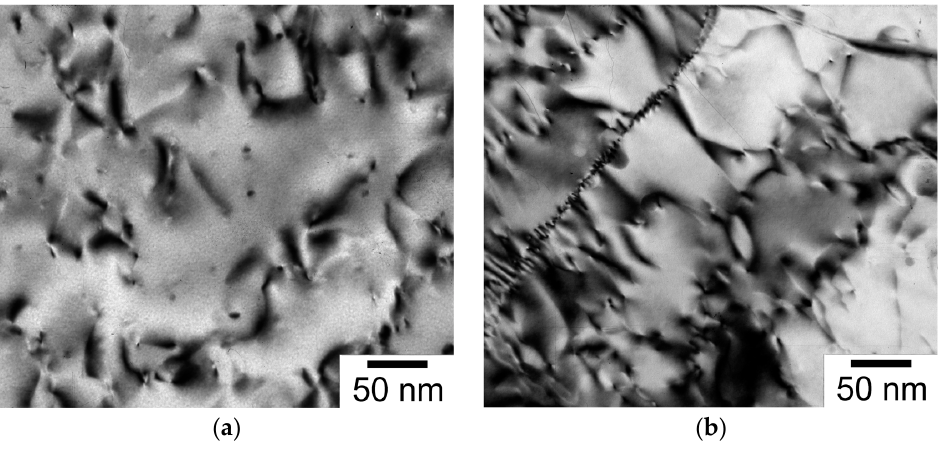
Figure 9. Microstructure of the 5024 alloy deformed till failure at 10 − 3 s − 1 : ( a ) coarse-grained state; ( b ) after ECAP. The TEM foils were cut approximately 10 mm far from fracture.